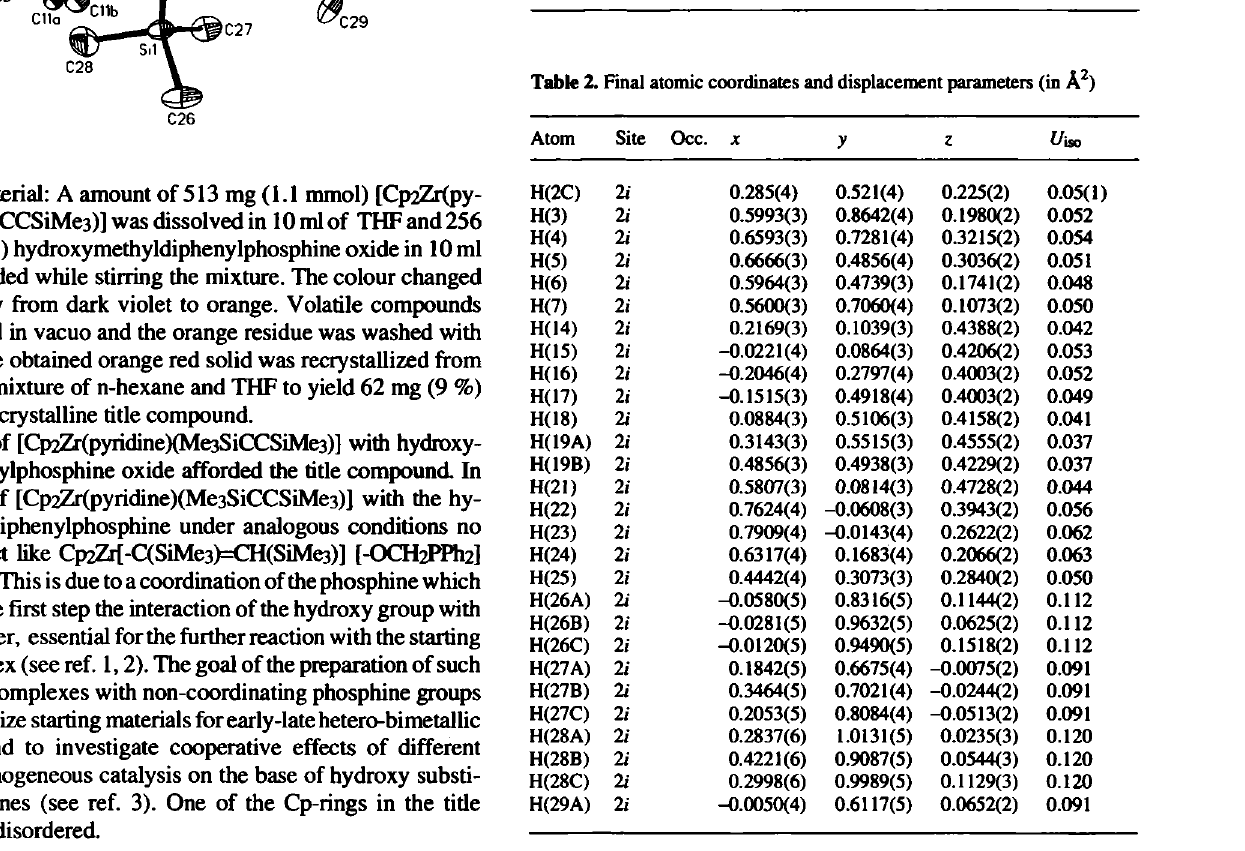
Table 2. Fmal atomic coordinates and displacement parameters (in